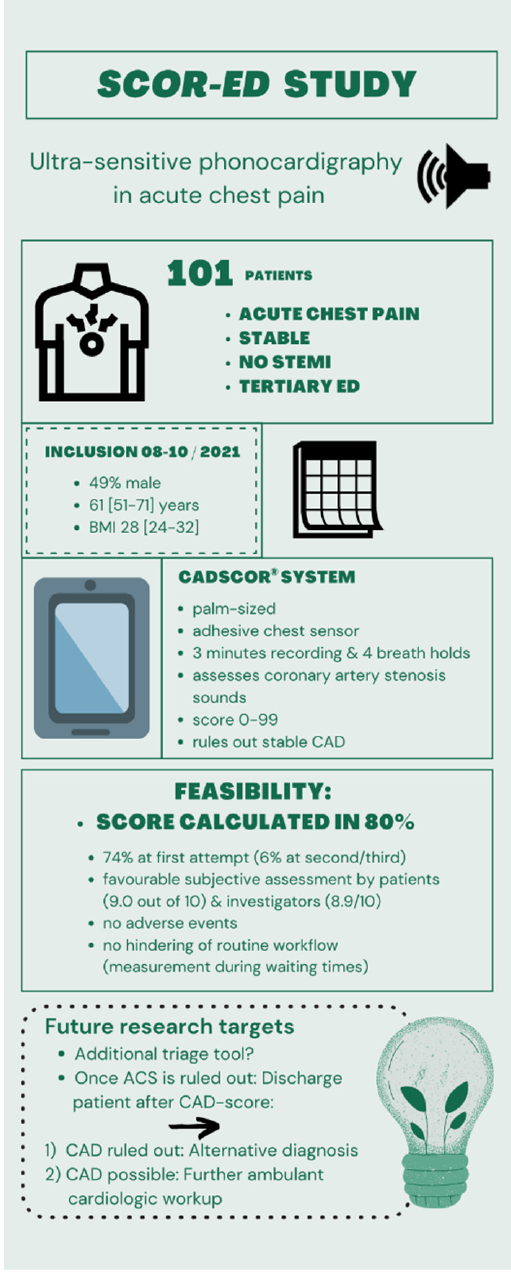
Figure 1. Overview of the main study findings. ED = emergency department; BMI = body mass index; CAD = coronary artery disease; ACS = acute coronary syndrome.